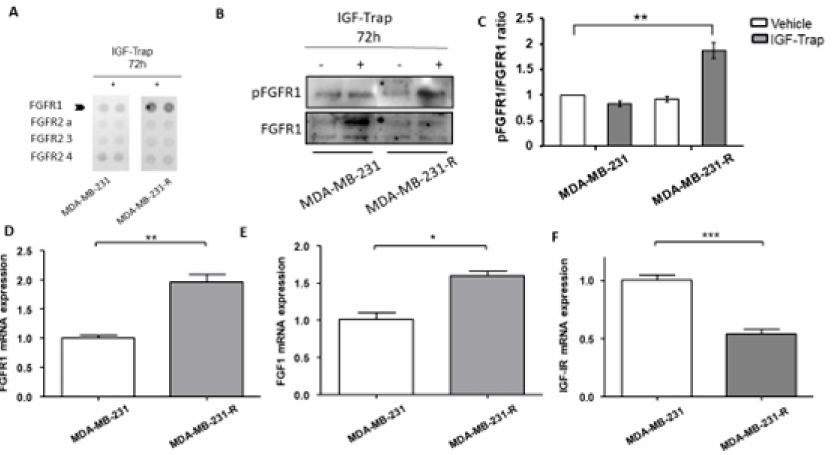
Figure 4. Upregulated expression and increased activation of FGFR1 in IGF-Trap resistant MDA-MB- 231-R cells. MDA-MB-231 and MDA-MB-231-R cells were treated with 315 µ g/mL IGF-Trap in the presence of serum for 72 h. A phopsho-RTK (receptor tyrosine kinase) array was then used ( A ) to profile phosphorylated RTKs in total cell lysates derived from these cells. Western blotting ( B ) and qPCR ( D – F ) were used to analyze activated FGFR1 ( B ) and mRNA expression ( D – F ) levels of the indicated transcripts in cells treated with 160 µ g/mL IGF-Trap for 72 hr prior to lysis. Shown in ( B ) is a representative immunoblot and in ( C ) the data expressed as pFGFR1/FGFR1 ratios normalized to the level in vehicle-treated MDA-MB-231 cells that were assigned a value of 1. Data in ( D – F ) were normalized to GAPDH and are expressed as means ( ± SE) fold change in transcript expression in MDA-MB-231-R cells relative to MDA-MB-231 cells that were assigned a value of 1 ( n = 4). * p < 0.05, ** p < 0.01, *** p <